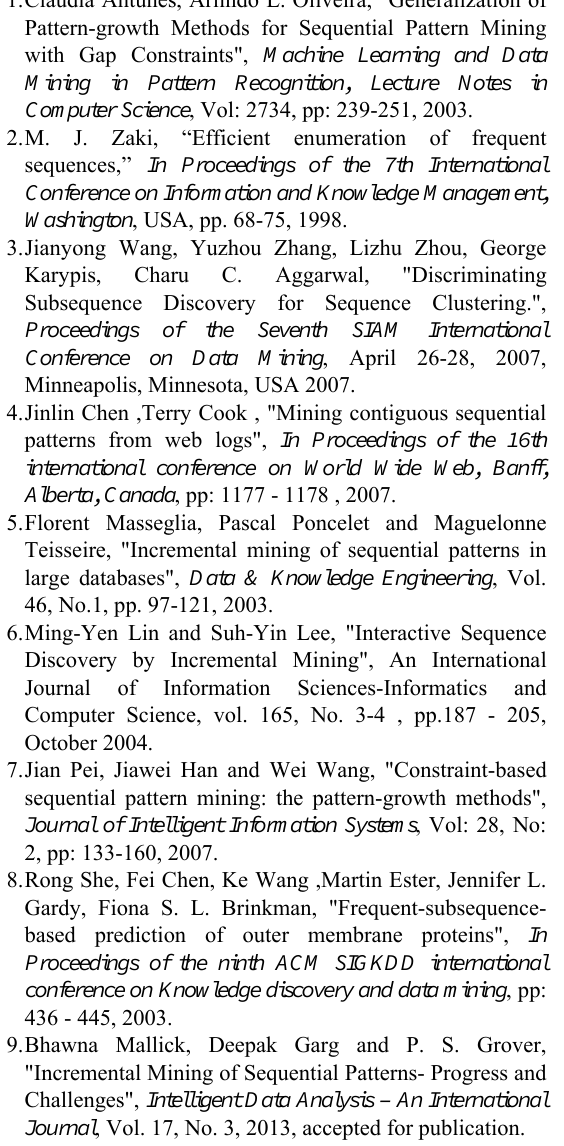
Fig.10. Execution Time Required With Different Support Values